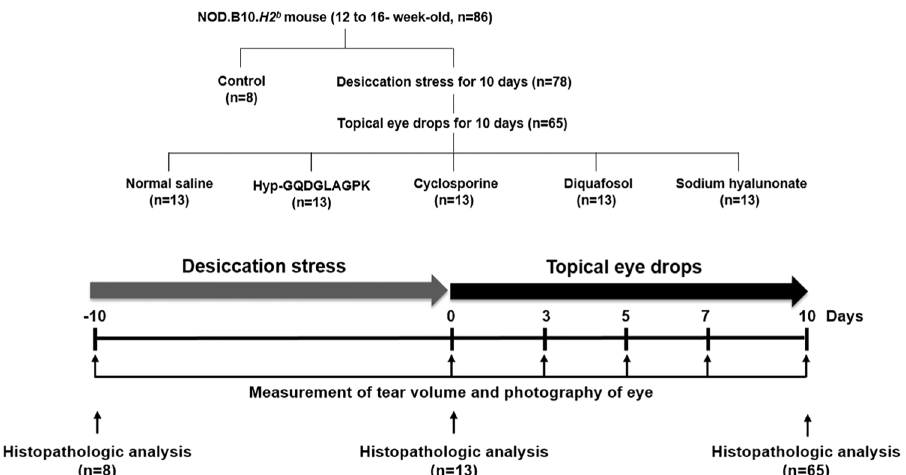
Figure 8. Experimental design of in vivo study. Dry eye was experimentally induced in sixty 12- to 16-week-old NOD.B10.H2 b mice by subcutaneous injections of scopolamine and exposure to an air draft for 10 days. Ten days later, the mice were randomly divided into five groups: the normal saline group (n = 13, 5 μ L of normal saline), the Hyp-GQDGLAGPK group (n = 13, 5 μ L of 1% Hyp-GQDGLAGPK), the cyclosporine group (n = 13, 5 μ L of Cyporin ® N 0.05%), the diquafosol group (n = 13, 5 μ L of Diquas ® ophthalmic solution 3%), and the sodium hyaluronate group (n = 13, 5 μ L of Hyaluni ® 0.1%). All treatments were administered five times per day. Tear volume and corneal smoothness were measured at baseline; after 10 days of desiccation stress; and after treatment for 3, 5, 7, and 10 days. Histopathologic analysis was performed before desiccation stress (n = 8, 16 eyes), immediately after desiccation stress for 10 days (n = 13, 26 eyes), and 10 days after treatment with Hyp- GQDGLAGPK, cyclosporine, diquafosol, and sodium hyaluronate eye drops, respectively (n = 13, 26